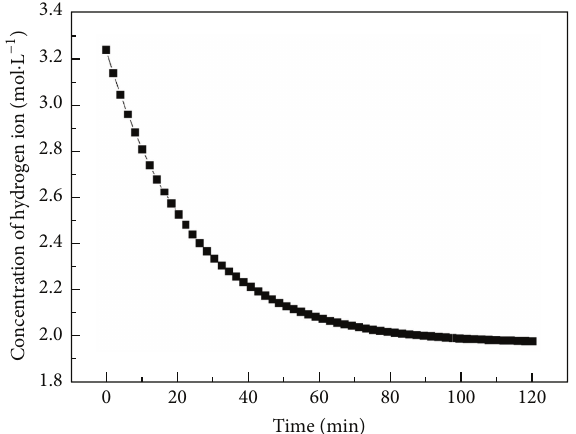
Figure 3: Hydrogen ion concentration at a given time (at 80 ∘ C).